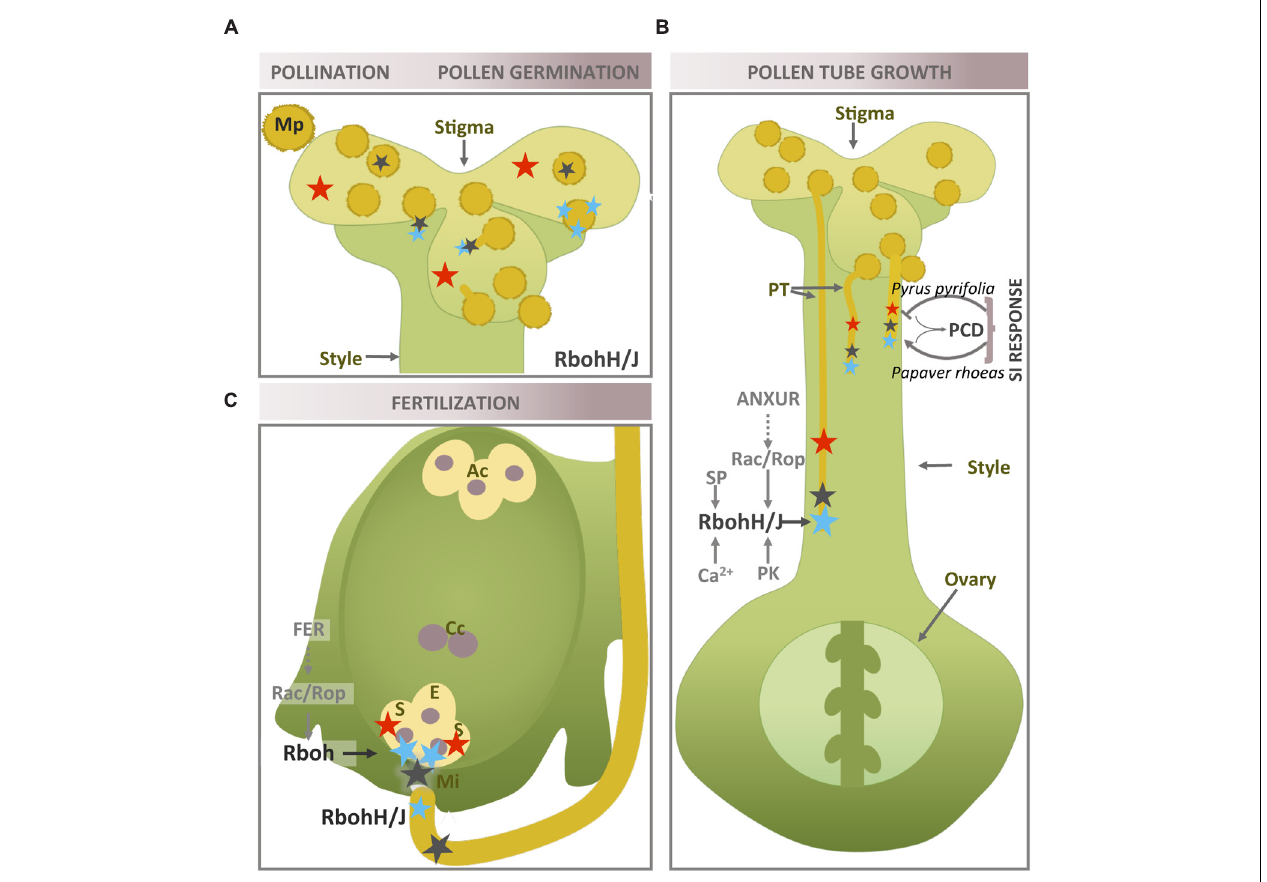
FIGURE 2 | Rboh-dependent superoxide production in plant reproductive tissues during pollen–pistil interaction. Location of O •− 2 in reproductive tissues during pollination and pollen germination (A) , pollen tube growth (B) and fertilization (C) . The location of H 2 O 2 and NO is also shown when necessary (more information in text above). Recognized superoxide sources and regulatory elements are marked in black. Blue star: O •− 2 ; red star: H 2 O 2 ; black triangle: NO; PT, pollen tube; Ac, antipodal cells; Cc, central cell; S, synergid; E, egg cell; PK, protein kinase; SP, signaling phospholipid; Mi,